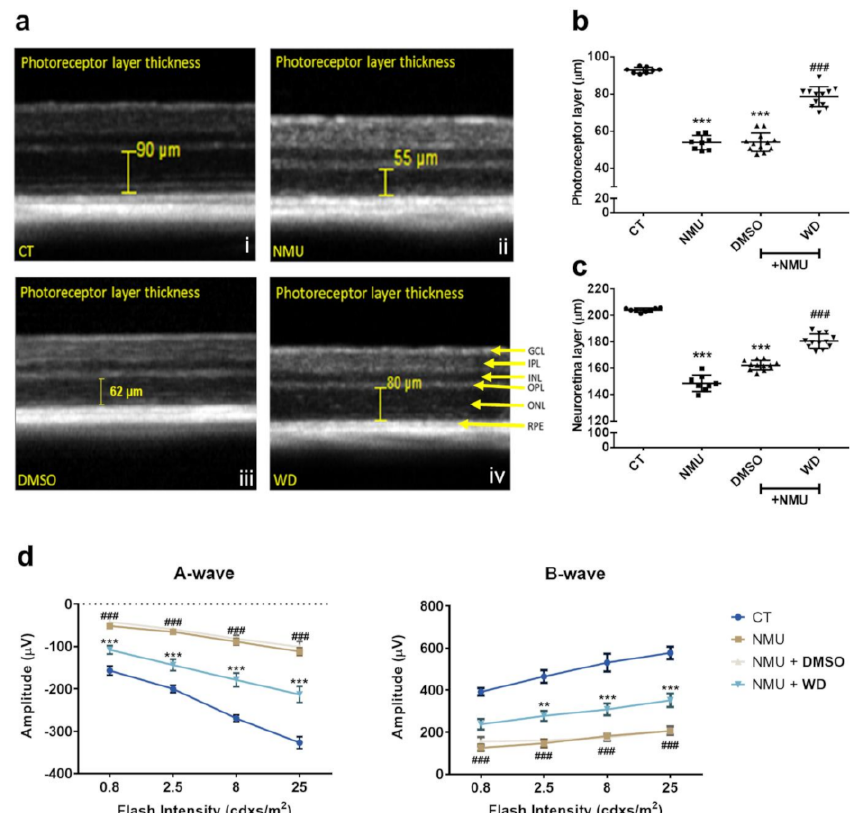
Figure 1. ( a ) Representative SD-OCT images derived from Heidelberg Spectralis software, displaying manual photoreceptor layer measurement (yellow measurement bar). ( b ) Quantitative analysis of the average photoreceptor layer thickness and ( c ) average neuroretina thickness was taken from four measurements (nasal, temporal, superior, and inferior) at 1500 µ m eccentricities from the optic disk, per eye. CT: n = 8, NMU: n = 8, NMU + DMSO: n = 12, NMU + WD: n = 12; n = number of individual mouse eyes. One-way ANOVA with Tukey’s post hoc test. *** p < 0.001 comparison to CT. ### p < 0.001 comparison between NMU + WD and NMU + DMSO. ( d ) Analysis of A- and B-wave amplitude. The retinas from each experimental group were stimulated with increasing light intensities (0.8, 2.5, 8, and 25 cdxs/m 2 ). CT: n = 6, NMU: n = 10, NMU + DMSO: n = 8, NMU + WD: n = 12; n = number of individual mouse eyes. Two-way ANOVA with Tukey’s post hoc test ** p < 0.01, *** p < 0.001 comparison between NMU + WD and NMU + DMSO. ### p < 0.001 comparison between NMU and CT. Error bars: mean ±